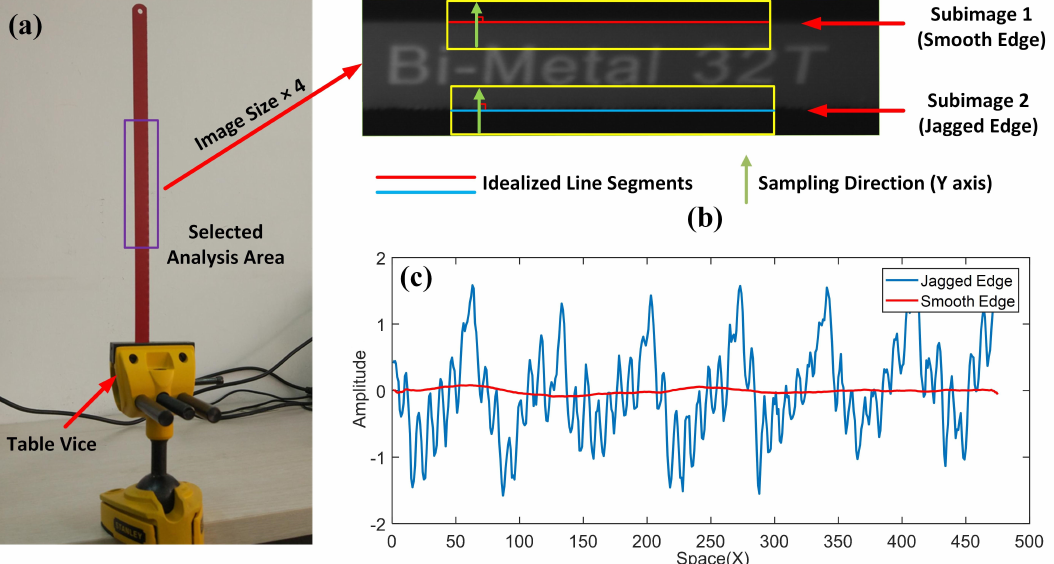
Figure 1. Experimental setups of the saw blade experiment: ( a ) saw blade and the selected analysis area; ( b , c ) schematic and extraction results of the saw blade